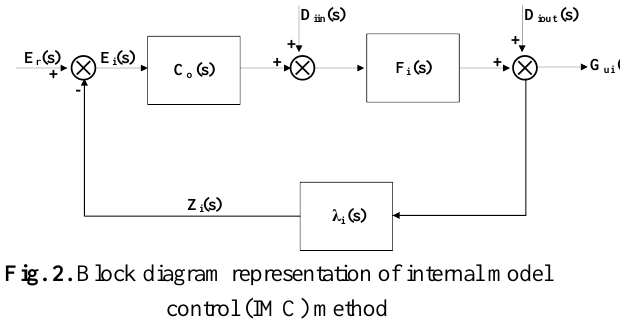
Fig. 2. Block diagram representation of internal model control (IMC)